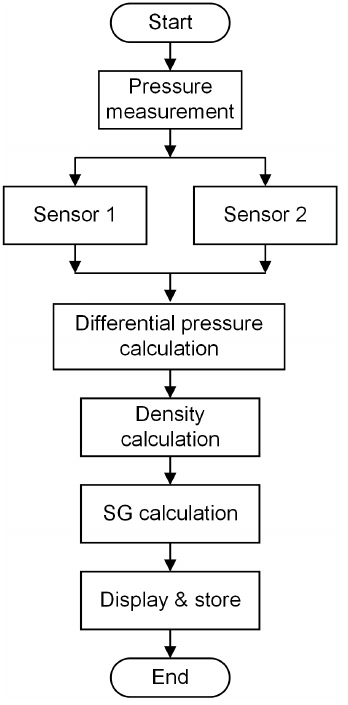
Figure 4. The flow chart of the Brix measurement process. Table 2. Performance specifications of the piezoresistive silicon pressure